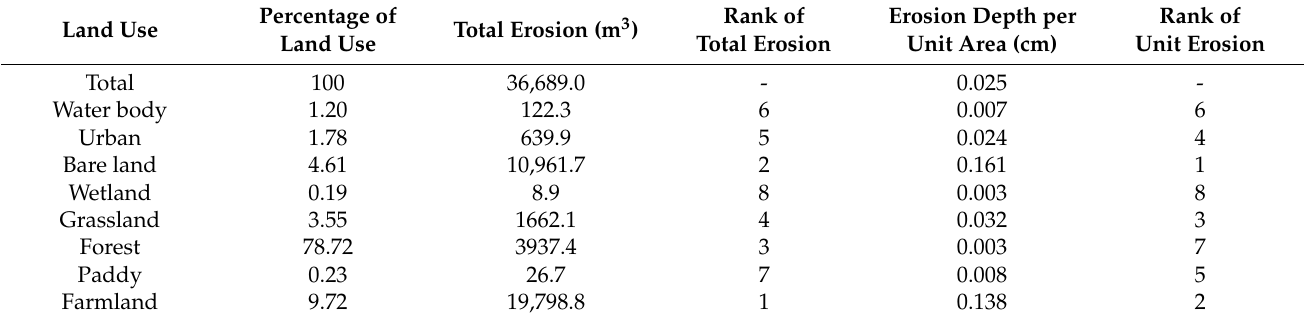
Table 8. Results of erosion for land use (the calibrated MR-SSEM, Typhoon